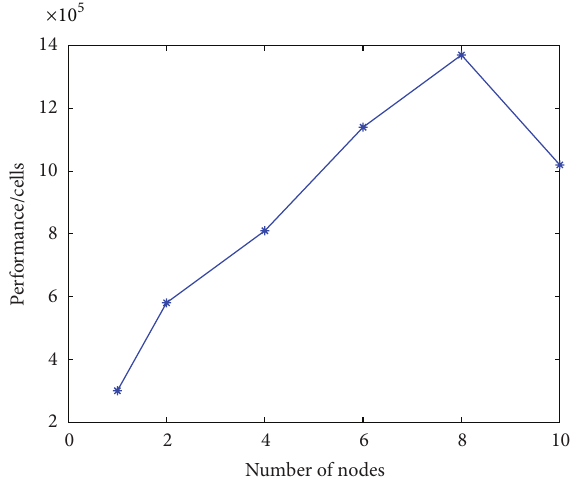
Figure 4: The performance of parallel CG-FFT.